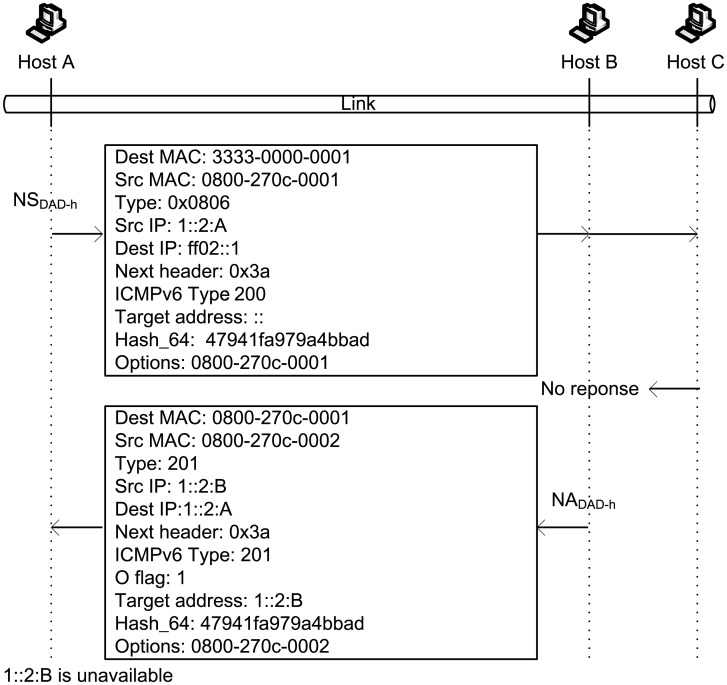
An example of DAD-h.